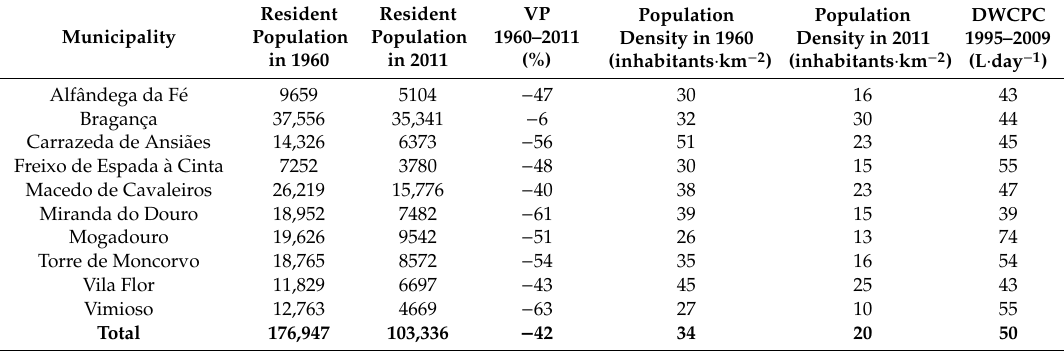
Table 1. The resident population in 1960 and 2011 and the variation in population per municipality according to Statistics Portugal [19]. The population density in 1960 and 2011 and the domestic water consumption per capita between 1995 and 2009 per municipality in the Sabor River basin. The domestic water consumption per capita is available at PORDATA [20]. The legend is: VP 1960–2011 (%), the variation in population between 1960 and 2011 (%); DWCPC 1995–2009 (L · day − 1 ), the domestic water consumption per capita between 1995 and 2009 (L · day − 1 ). Resident Resident Municipality Population in 1960